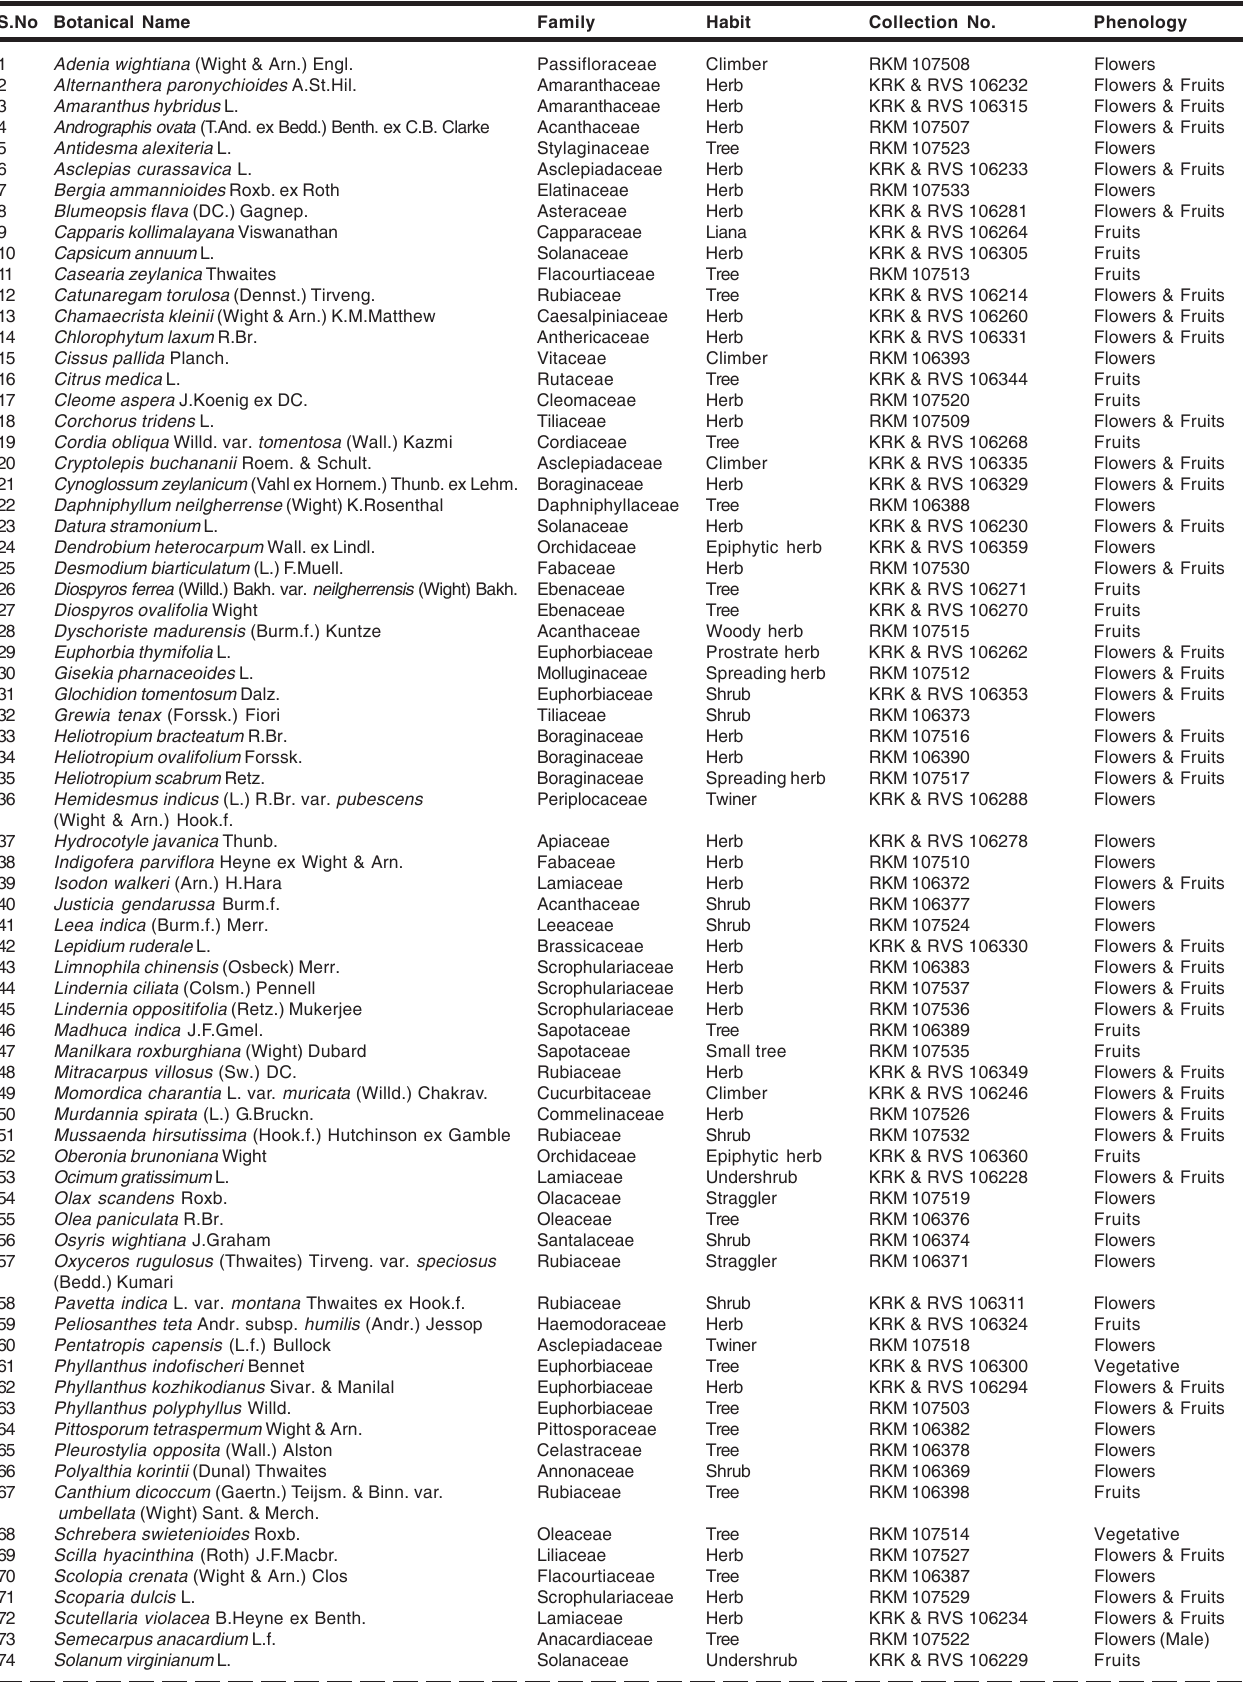
Table 1. List of plant species added to the flora of Sirumalai